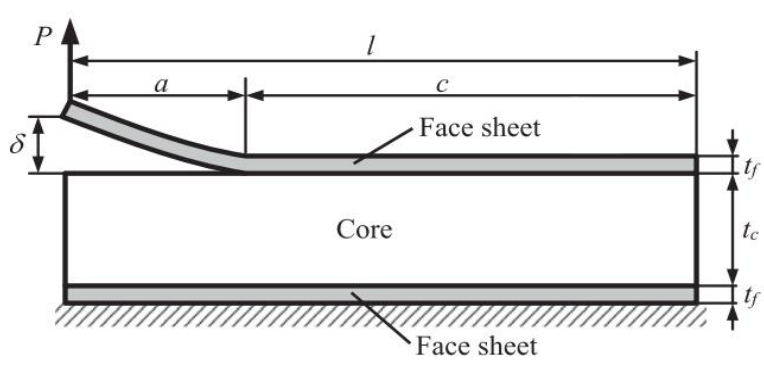
Figure 1. Single cantilever beam Mode-1 fracture test (SCB) configuration.